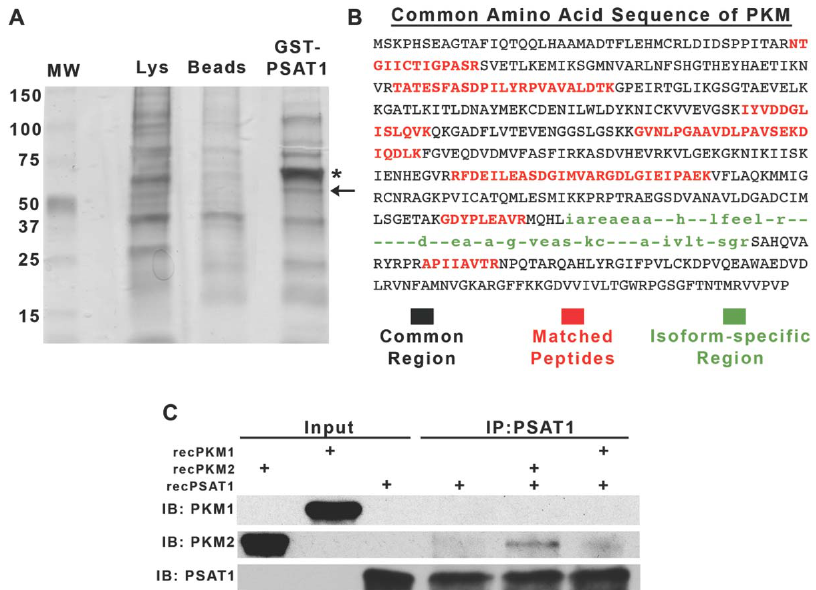
Figure 1. PKM2 is a novel binding partner of PSAT1. ( A ) Silver stain of GST ‐ PSAT1 ‐ purified proteins from A549 whole ‐ cell lysates. * Denotes residual GST ‐ PSAT1 from column purification; ← denotes gel slice encompassing PKM. ( B ) Primary amino acid sequence of human PKM. MS ‐ identified peptides of PKM are highlighted in red. Black ‐ labeled sequences belong to common regions of both PKM1 and PKM2 isoforms and green ‐ labeled sequences identify isoform specificity. ( C ) Co ‐ IP of recombinant (rec ‐ ) PSAT1 and PKM1 or PKM2. Immunocomplexes were precipitated using an anti ‐ PSAT1 antibody and analyzed by immunoblot using anti ‐ PKM1, anti ‐ PKM2, and anti ‐ PSAT1 antibodies. Recombinant proteins were used as input controls showing antibody specificity and PSAT1 alone was used as an IP control. Shown are representative images from two separate experiments. Based on this interaction, we hypothesized that a PKM2 ‐ specific region may contrib ‐ ute to a PSAT1 association. Three ‐ dimensional modeling of human PKM1 and PKM2 demonstrates that they have a 95.8% sequence homology and have the same overall struc ‐ ture. As depicted in Figure 2A, an isoform ‐ specific region (cyan) is localized to a loop structure within the respective monomers. We mutated amino acid residues in wild ‐ type (WT) PKM2 to the corresponding PKM1 residues by site ‐ directed mutagenesis (Figure 2A, mutations highlighted in red). A Co ‐ IP analysis involving a FLAG ‐ tagged PKM2 WT and mutant (MT 1–4) proteins revealed that mutations in MT 1, 2 and 4 did not substantially affect the interaction with PSAT1 (Figure 2B). However, the amino acid changes within MT3 ‐ PKM2 that are inclusive of mutations in both MT 2 and 4 strongly reduced the bind ‐ ing to endogenous PSAT1. Together, the recombinant co ‐ IP and mutational analysis demonstrate a specific PSAT1–PKM2 interaction.